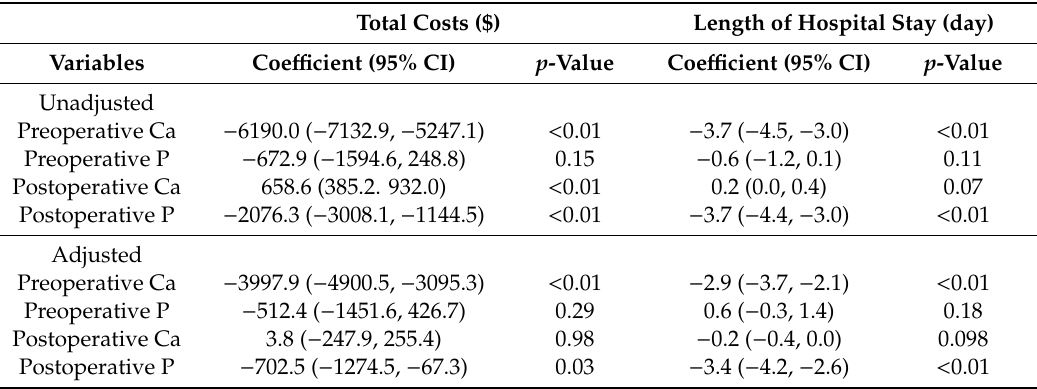
Table 3. Linear regression analysis for total costs ($) and length of hospital stay (day) after major abdominal surgery according to perioperative serum Ca and